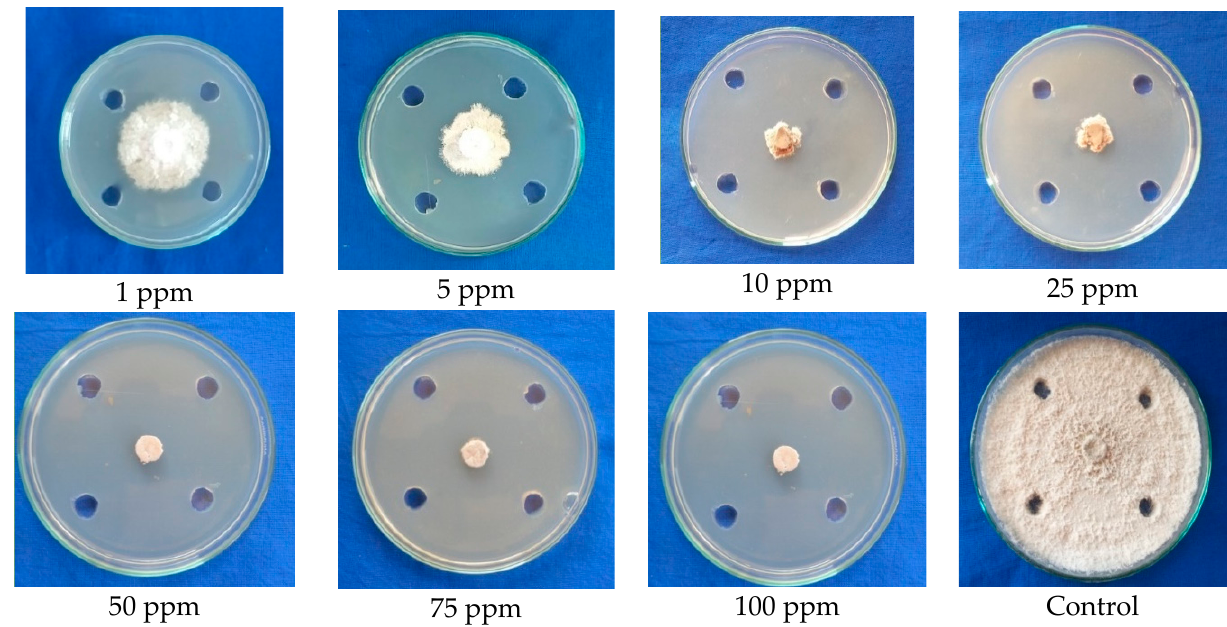
Figure 5. Conformation of the antifungal efficacy of benzothiazole at different concentrations against mycelial growth of C. gloeosporioides (Agar well test). Table 4. Testing the antifungal efficacy of benzothiazole at different concentrations against mycelial growth of C. gloeosporioides.